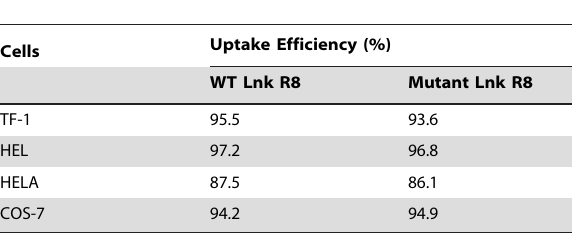
Table 1. Uptake rate of Lnk R8 fusion proteins.